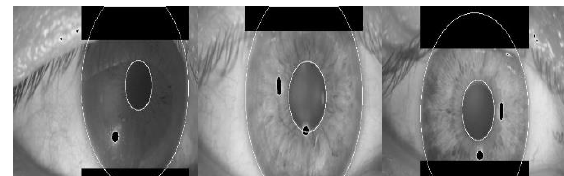
Figure 8. Automatic segmentation of various images from the MMUI database.